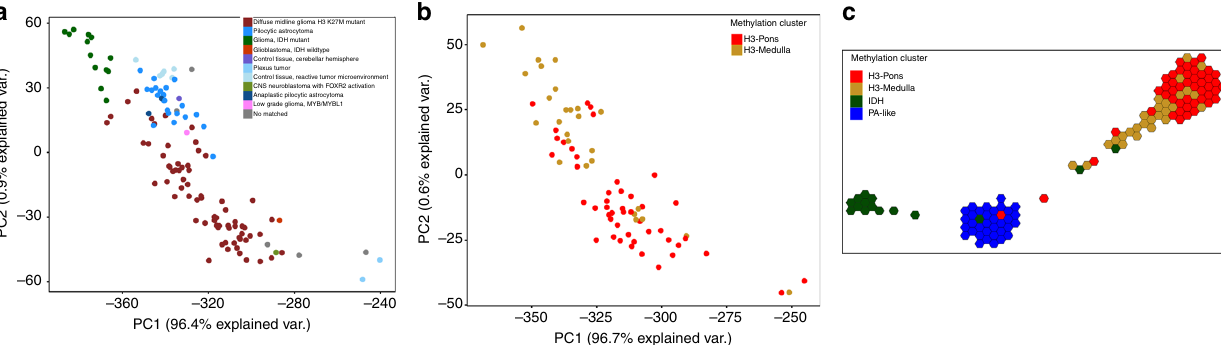
Fig. 2 Visualization of methylation status in brainstem gliomas. a Principal component analysis of whole probes of methylation status, colored by DKFZ classi fi er. b PCA of whole probes for tumors from H3-Medulla and H3-Pons only, colored by clusters de fi ned in Fig. 1. c Tumor map from whole probes, colored by methylation